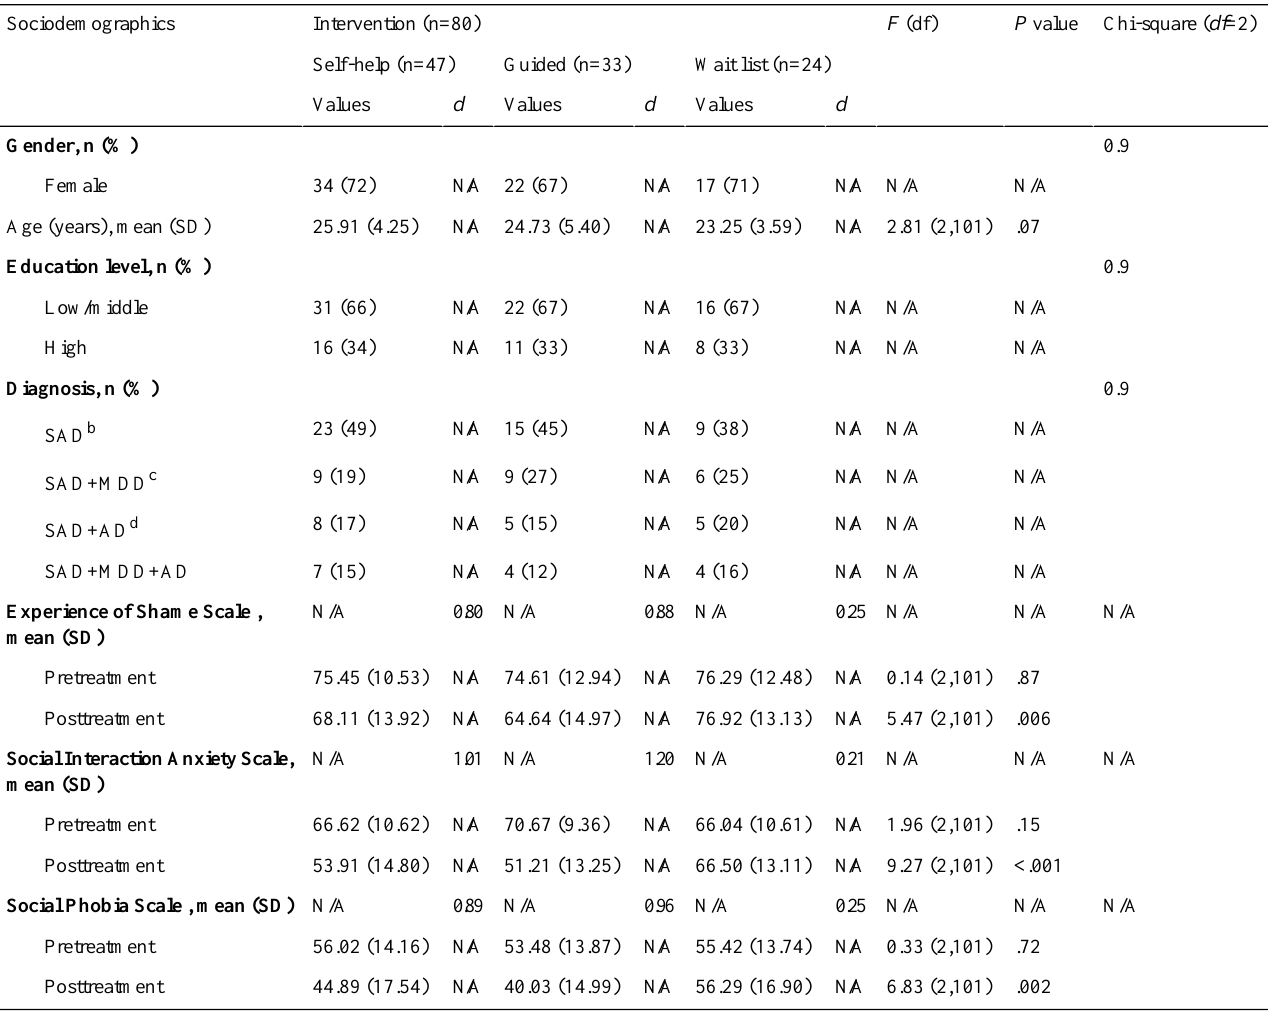
Table 1. The descriptive statistics of all variables before and after the